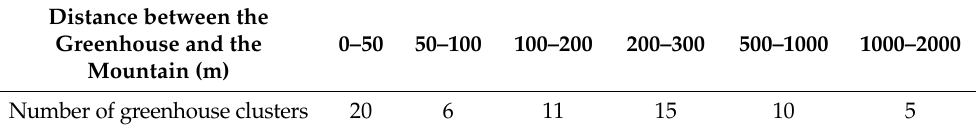
Table 1. The number of greenhouse clusters according to different distances from the mountain. Distance between the